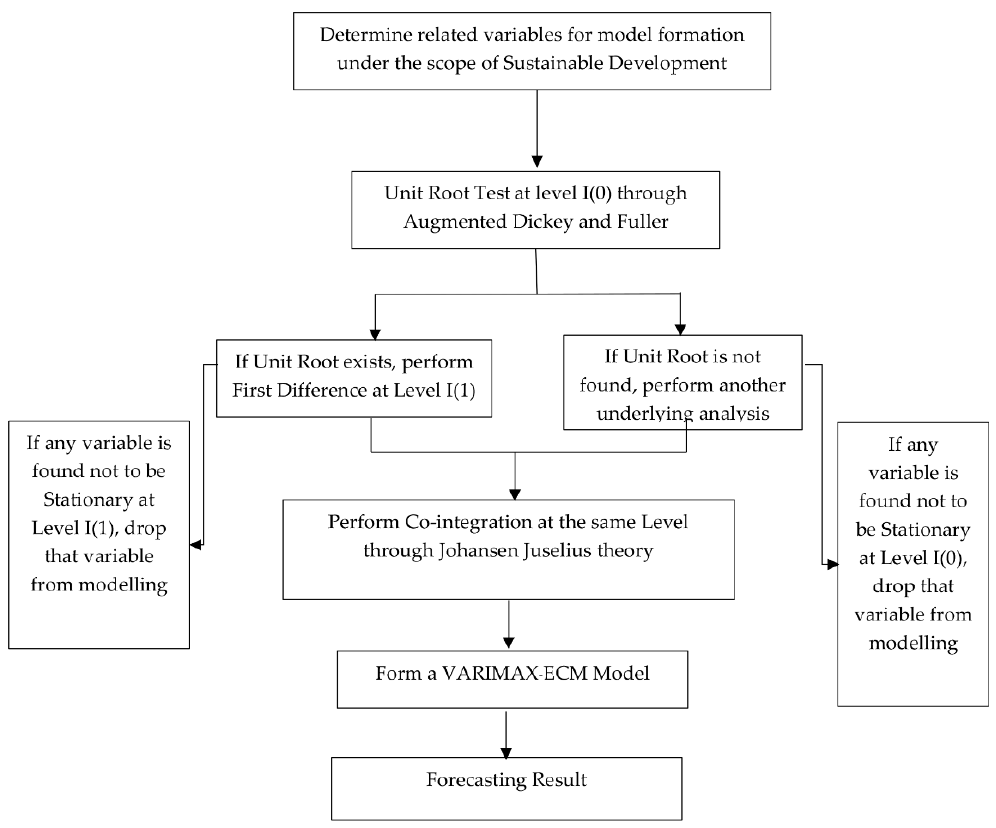
Figure 1. The flowchart of the VARIMAX-ECM Figure 1 . The flowchart of the VARIMAX-ECM model.